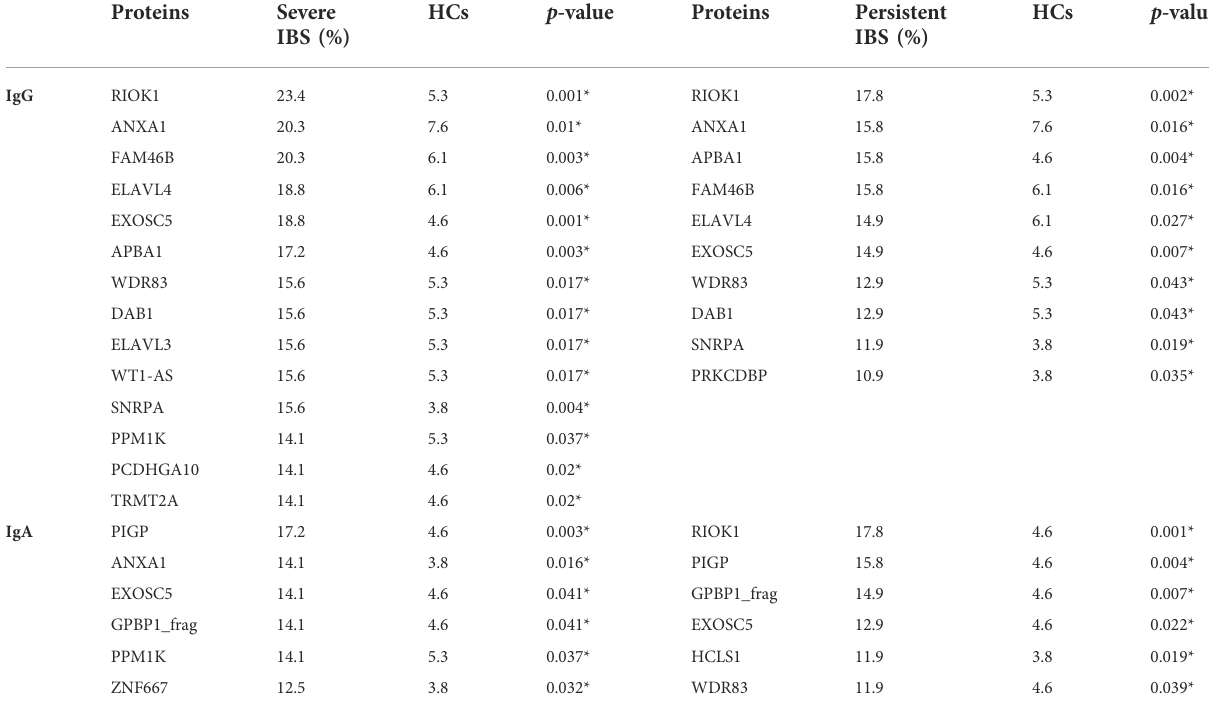
TABLE 3 Comparison of the positive rates of IBS-associated autoantigens among IBS subgroups and HCs.